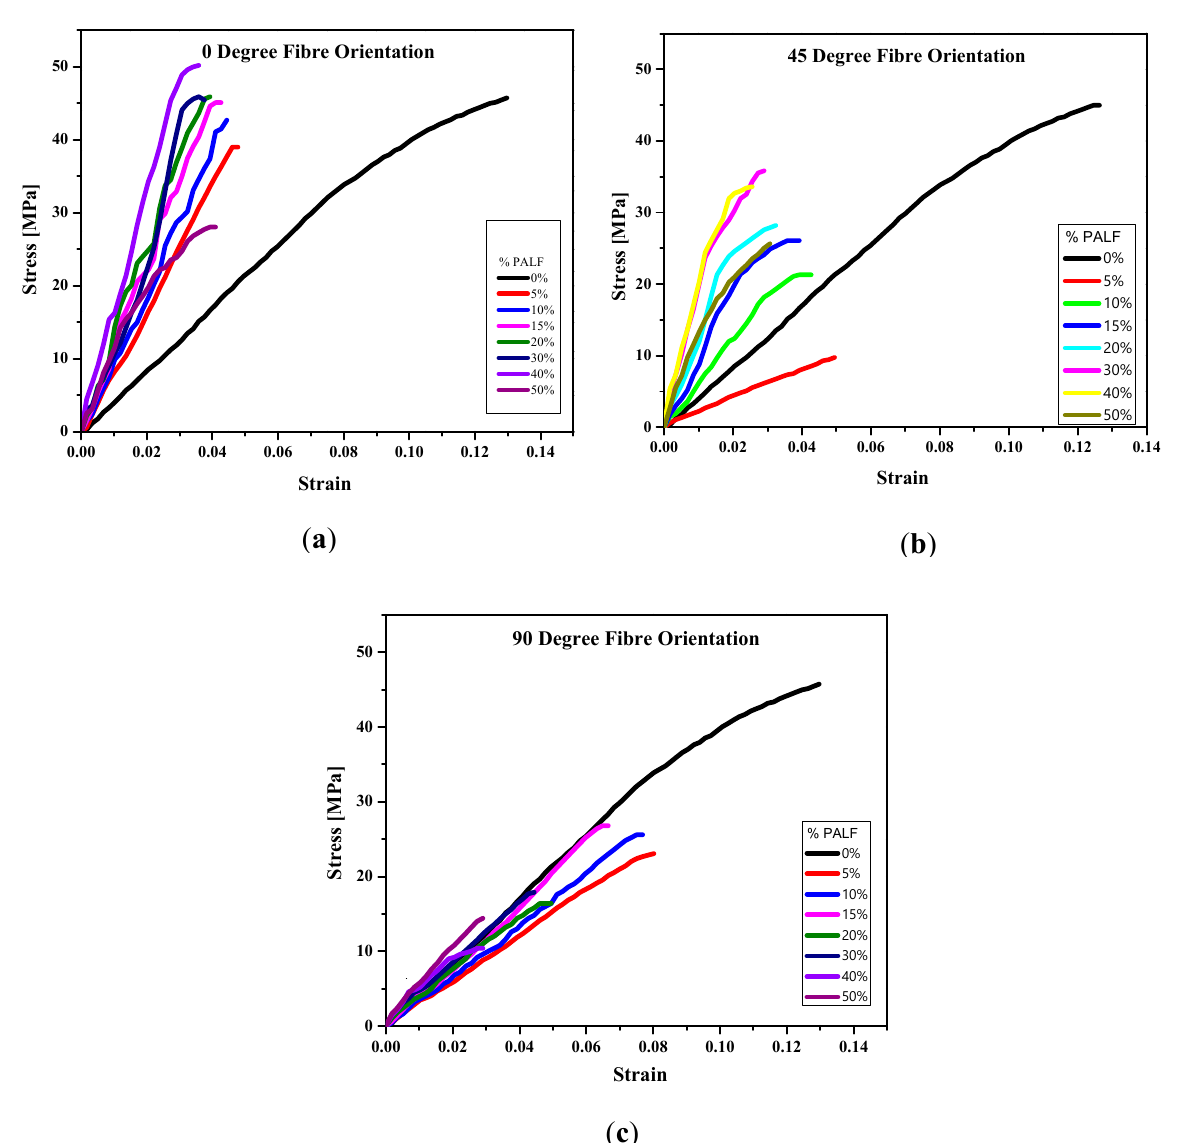
Figure 2. Stress–strain curves for PALF/MMA composites with varying fiber volume fractions oriented at: ( a ) 0°, ( b ) 45° and ( c ) 90°.